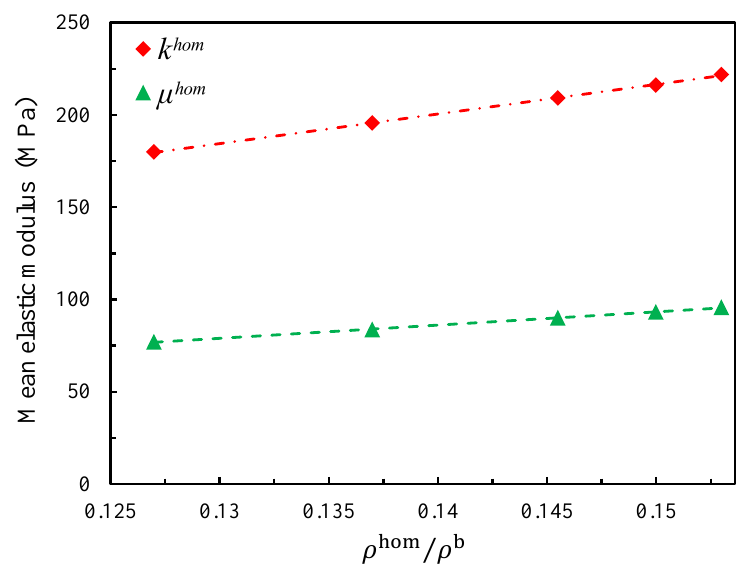
Figure 11. Effect of the relative density on the effective elastic moduli.